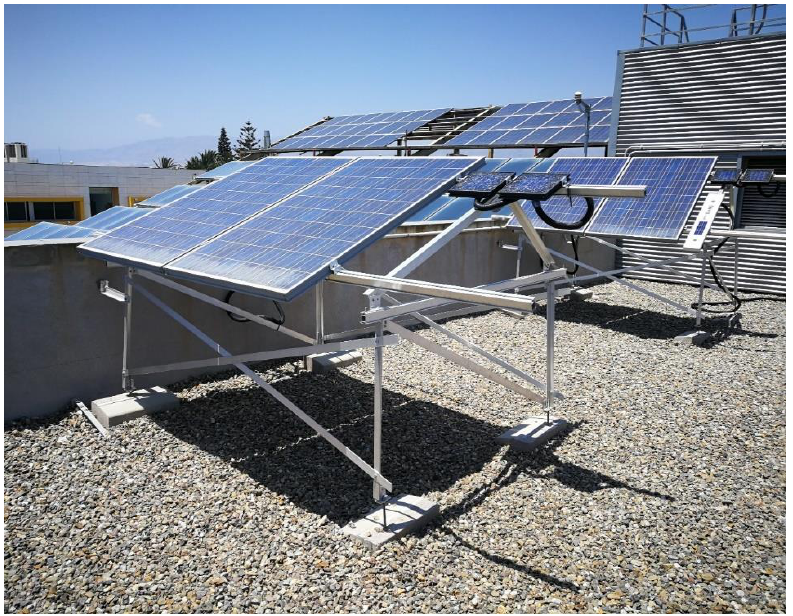
Figure 1. Experimental photovoltaic plant.